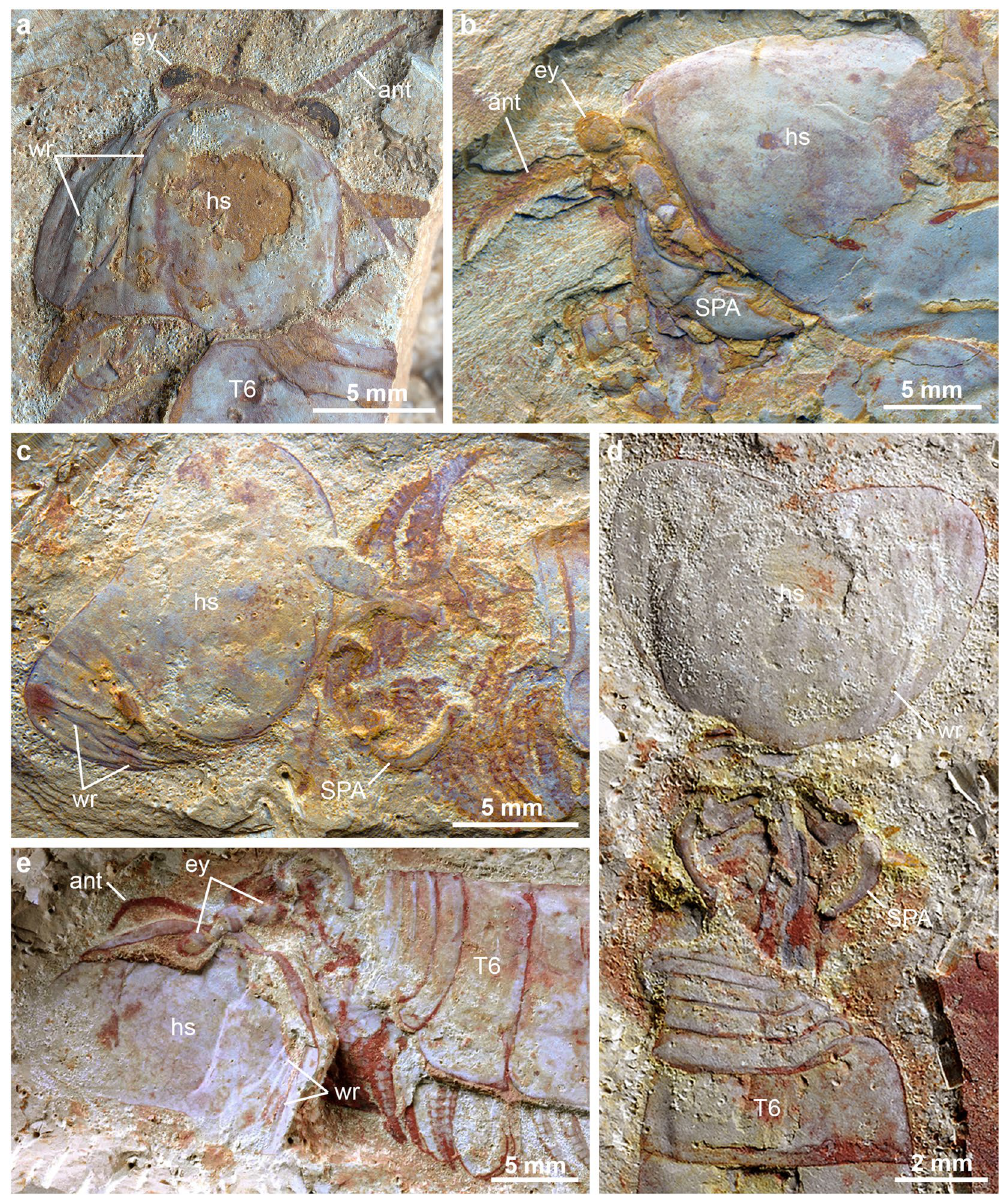
Figure 3. Taphonomic variability in specimens of Alacaris mirabilis and Chengjiangocaris kunmingensis from the early Cambrian Xiaoshiba biota. ( a ) Alacaris mirabilis , YKLP 12270, individual preserved in the act of moulting with wrinkled head shield, eyes and antennae in life position. ( b ) A. mirabilis , YKLP 12272, specimen preserved in life position. The presence of articulated eyes and antennae with the head shield, and absence of cuticular wrinkles, indicate that this specimen is a carcass from an inter-moult individual. ( c ) A. mirabilis , YKLP 12276, specimen preserved with ‘taphonomic dissection’, defined by the disarticulation of the head shield whilst still partially attached to the body anteriorly; note the presence of wrinkles on the head shield resulting from post-mortem compaction and decay. ( d ) Chengjiangocaris kunmingensis , YKLP 12020. ( e ) C. kunmingensis , YKLP 12024, specimen preserved with ‘taphonomic dissection’. Abbreviations: SPA, specialised post-antennal appendages; others as in Fig.